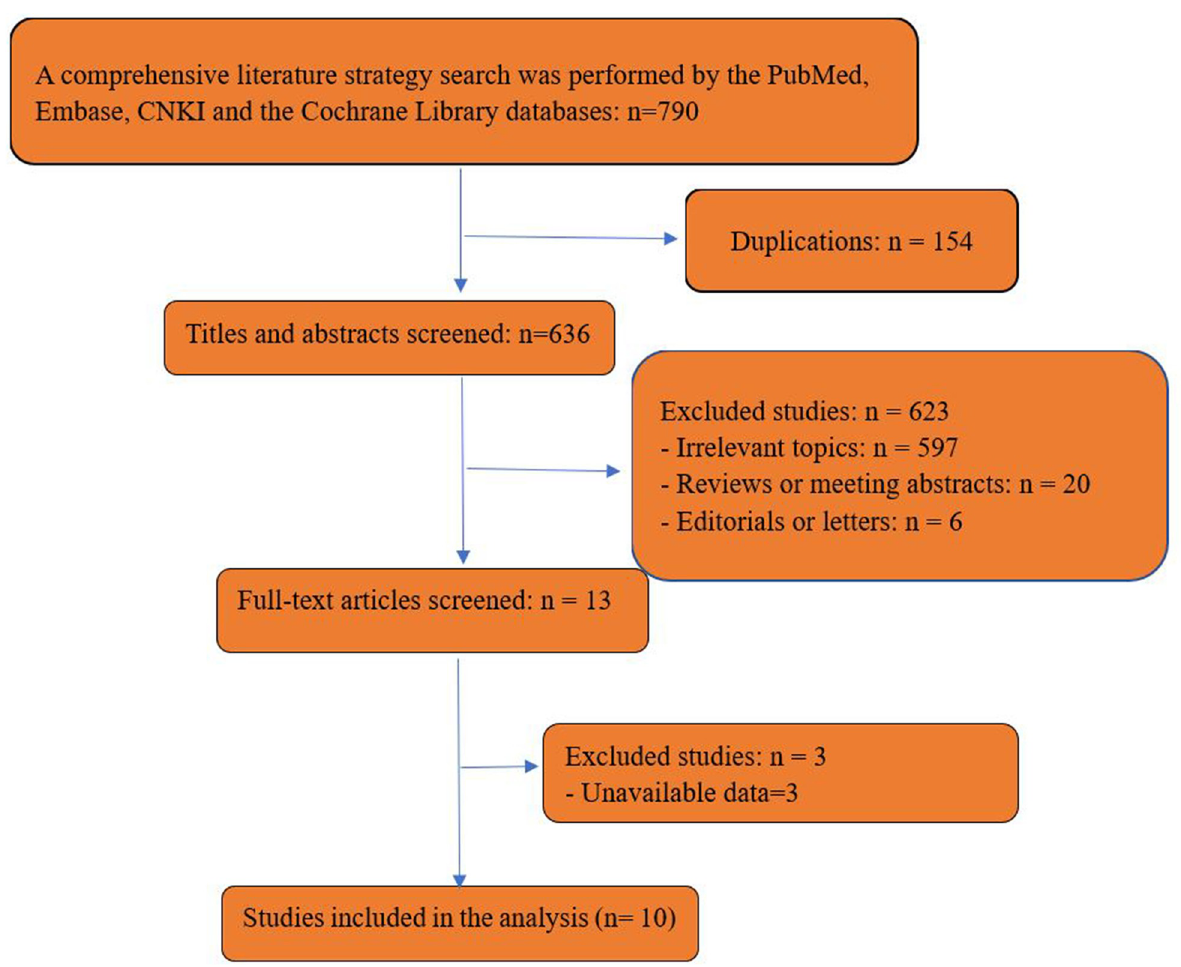
Fig 1. Flow diagram of studies identified, included, and